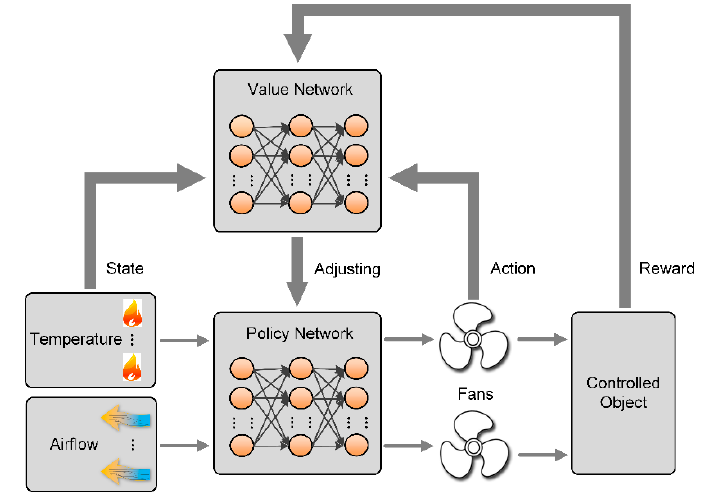
Figure 6. Schematic diagram of the on-line reinforcement learning control method for the thermal and energy management.